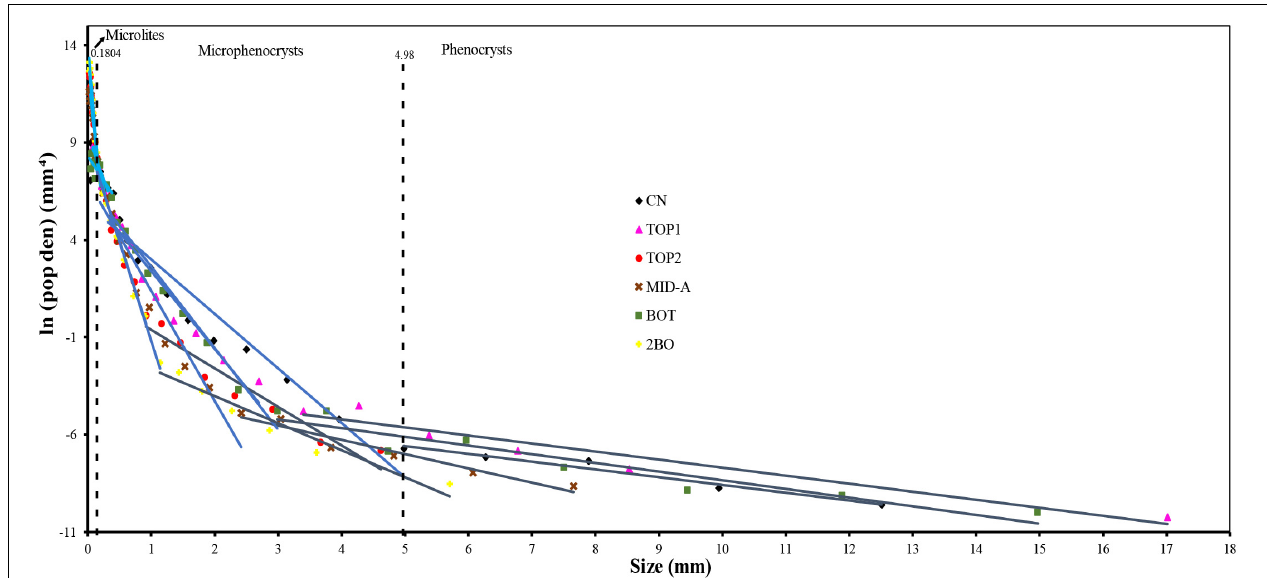
FIGURE 7 | CSD for each sample showing the population density (pop den) fraction versus the size of crystals. Dotted lines delimit the crystals families: microlites, microphenocrysts and